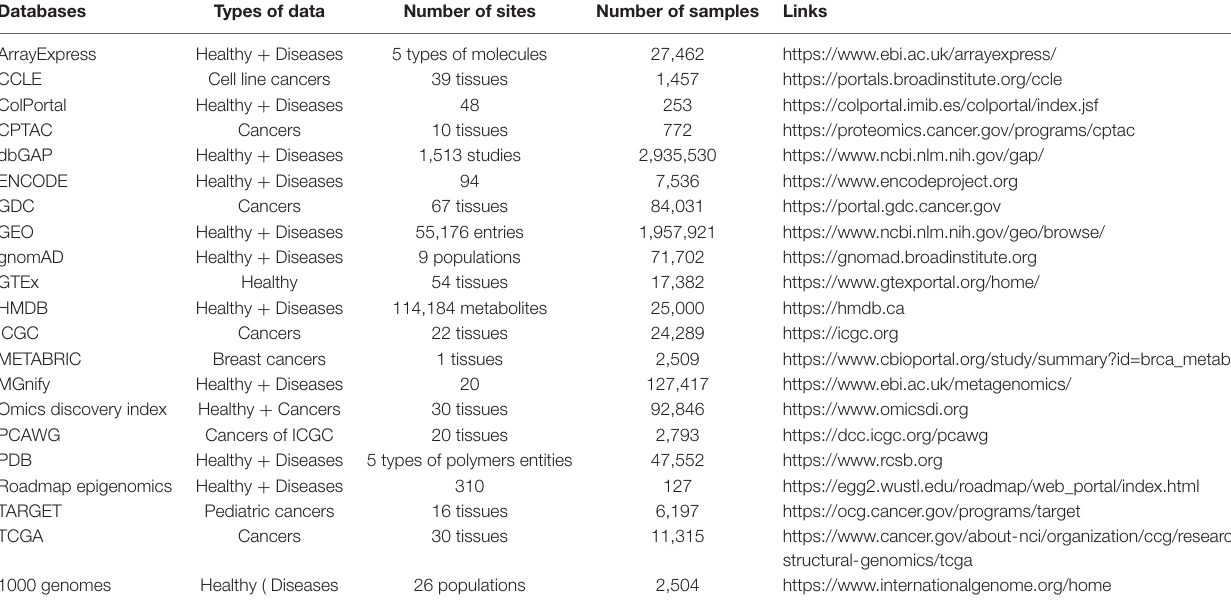
TABLE 3 | Non-exhaustive list of the main public omics databases (listed alphabetically). Databases Types of